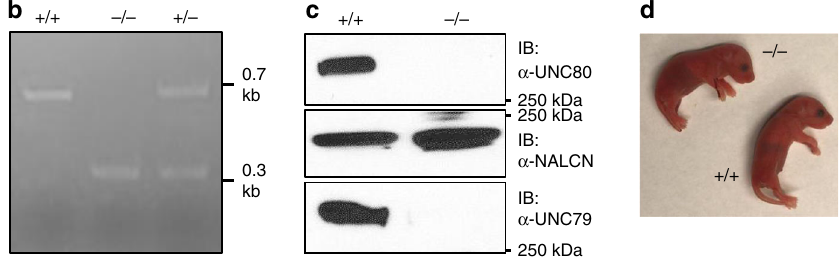
Fig. 1 Targeted disruption of UNC80 leads to apnea and neonatal lethality. a The design of UNC80 knockout (KO) using the CRISPR technique to delete exon 3. Exon 3 sequence is in capital and the surrounding introns are in lower case. The 5 ′ and 3 ′ target sequences including the PAM motif (XGG) against which the two CRISPR sgRNAs targeted are underlined. Deleted sequences including exon 3 and part of the surrounding introns are shaded. Deletion of exon 3 (total of 157 nucleotides) leads to truncation after V47. The codon encoding R51 (CGA) corresponding to the residue mutated to a stop codon found in human patients are in red. PCR primers used for genotyping in b are in italic and boxed. b Genotyping PCR products from WT ( + / + ), heterozygote ( + / − ), and homozygous KO ( − / − ) pups using primers in a . c Total brain proteins from + / + and UNC80 − / − were blotted with anti- UNC80 (upper), anti-NALCN (middle), or anti-UNC79 (lower) antibody. d Representative appearances of WT and KO P0 pup. For ( b ) and ( c ), three or more independent repeats were performed with similar results. For apnea phenotype in the KO, see Supplementary Movie 1. Source data are provided as a Source Data fi